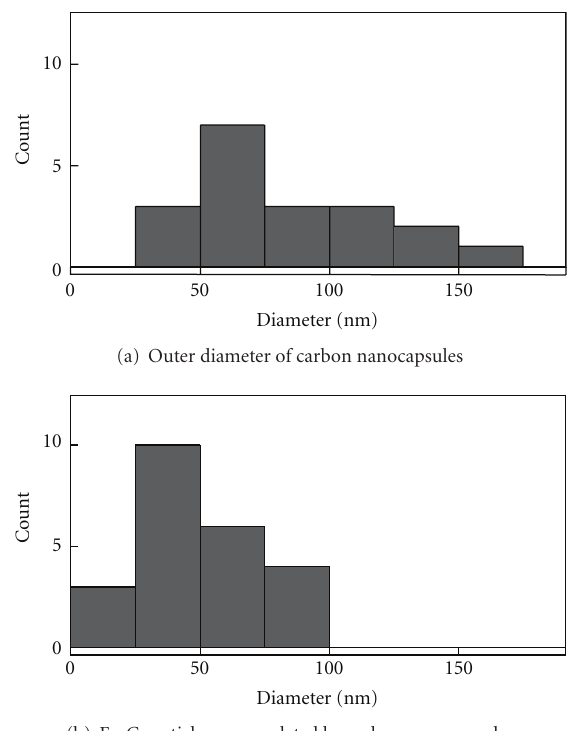
Figure 7: Histograms of (a) outer diameter of carbon nanocapsules and (b) Fe 3 C particles encapsulated by carbon nanocapsules.